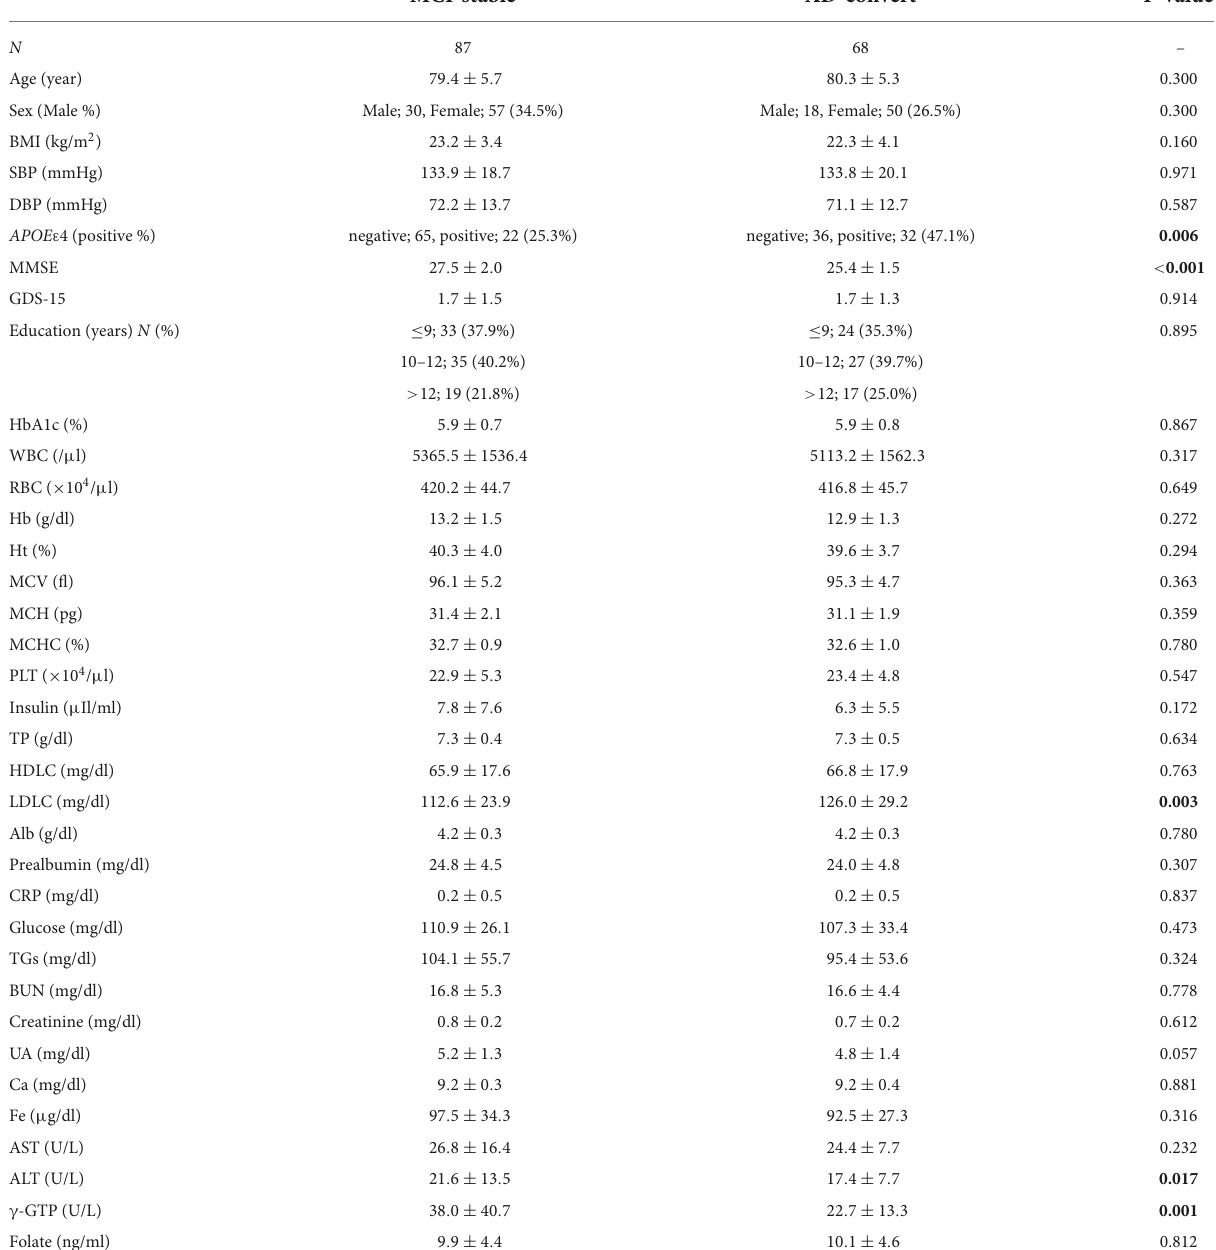
TABLE 1 Baseline characteristics of